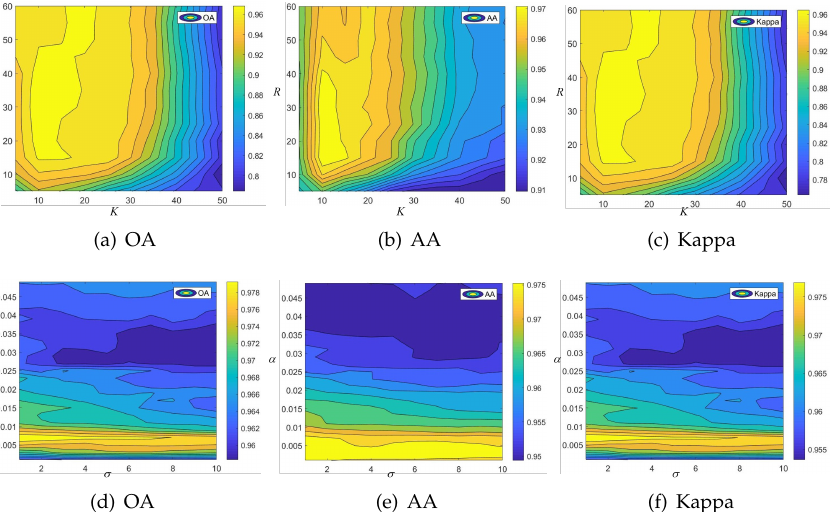
Figure 8. The influences of different free parameters on the classification performance of the proposed method. ( a ) OA obtained by the proposed method with different R and K . ( b ) AA obtained by the proposed method with different R and K . ( c ) Kappa obtained by the proposed method with different R and K . ( d ) OA obtained by the proposed method with different α and σ . ( e ) AA obtained by the proposed method with different α and σ . ( f ) Kappa obtained by the proposed method with different α and σ